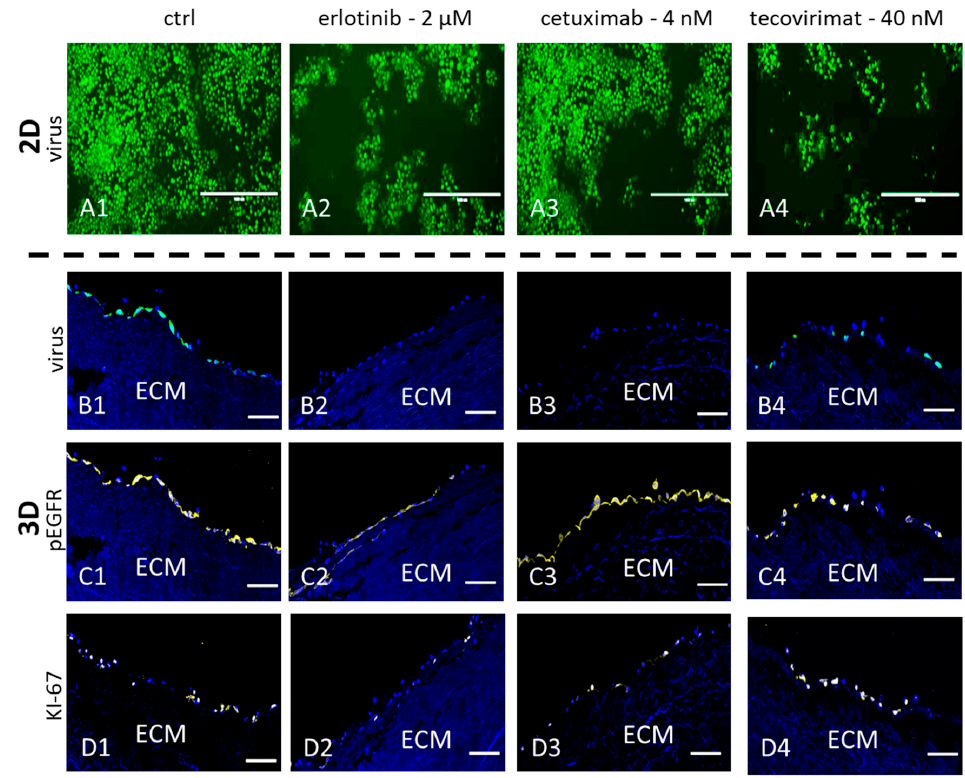
Figure 5. Immunofluorescence assay (IFA) analysis of CPXV infected 2D and 3D cultures treated with different antiviral substances. NHEK cultures were cultured with DMSO as a control (ctrl), 2 µM erlotinib, 4 nM cetuximab or 40 nM tecovirimat and infected with CPXV for 48 h. In 2D cultures and 3D cryosections infected cells were visualized by GFP (green) expression ( A , B ). In 3D cultures cellular nuclei were counterstained with DAPI (blue). Phosphorylated EGFR ( C ) and the cellular proliferation marker KI-67 ( D ) were labelled with specific rabbit polyclonal antibodies and visualized with AF647 (yellow) conjugated anti-rabbit secondary antibodies. Scale bar = 100 µ